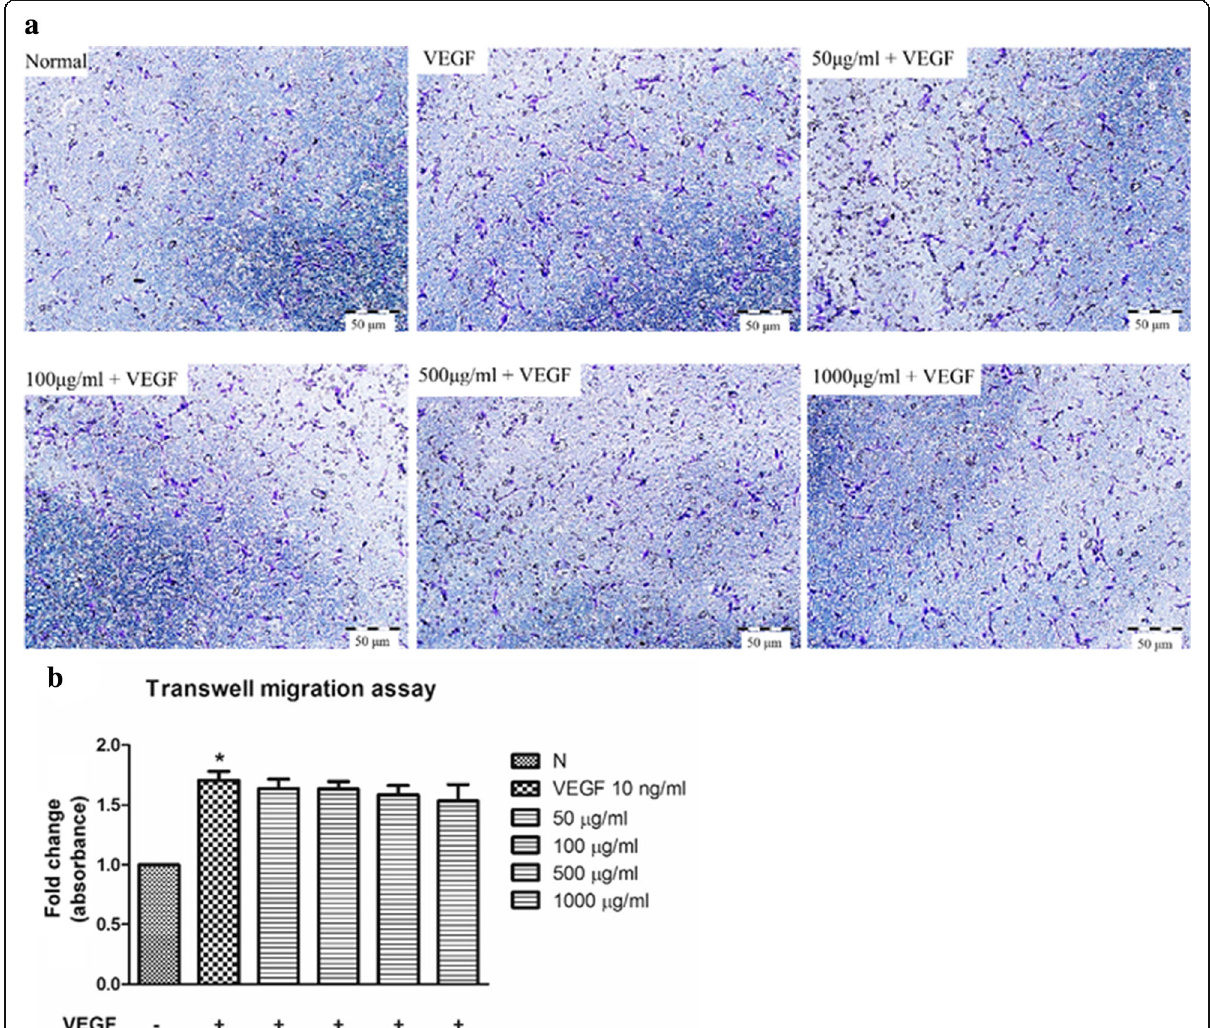
Fig. 5 Effect of C. nutans water extract on VEGF-induced transwell migration. HUVECs were treated with 50-1000 μ g/ml of the water extract for 6 h. a The cells were stained with 0.1% crystal violet. Representative results were shown. b Quantitative analysis of crystal violet intensities using a microplate reader. The values presented are the mean ± SEM of three independent experiments. * p < 0.05 were considered significant